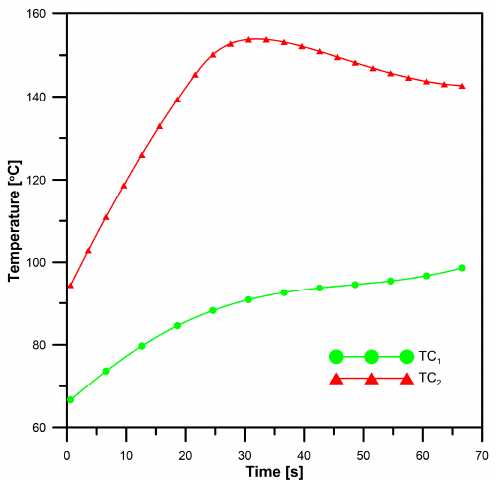
Figure 12. “Measured” temperature histories in points TC 1 and TC 2 from the system restart.